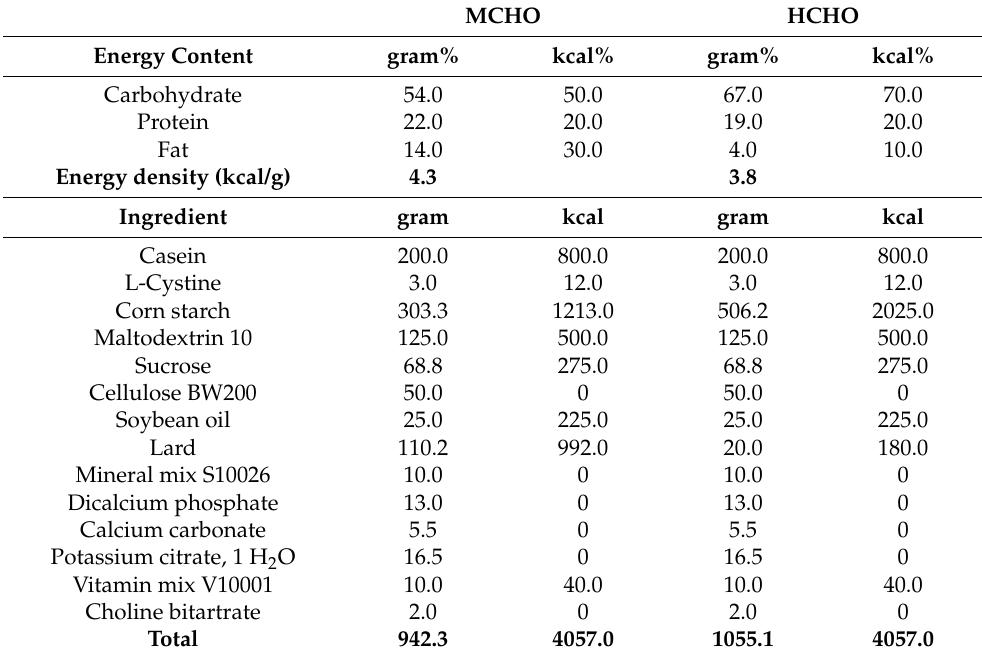
Table 1. Composition of the experimental